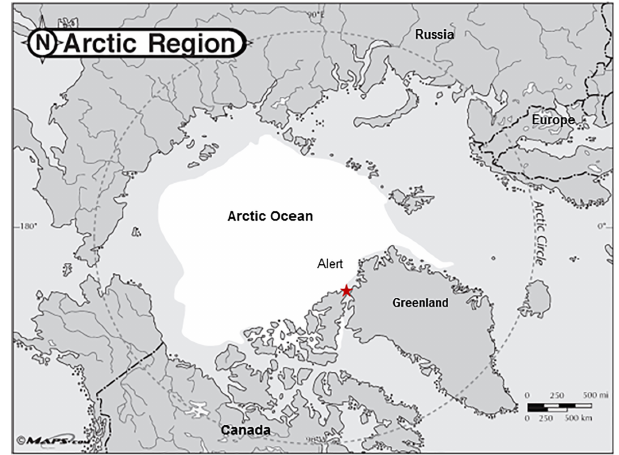
Figure 1. Alert (red star) is located at the northwest tip of Ellesmere Island in Nunavut, Canada, at 82 ◦ N and 62.5 ◦ W at an altitude of